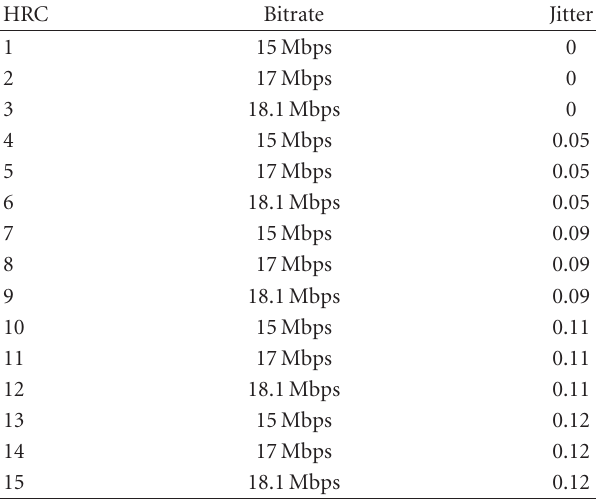
Table 1: The HRC profiles that were tested during quantitative